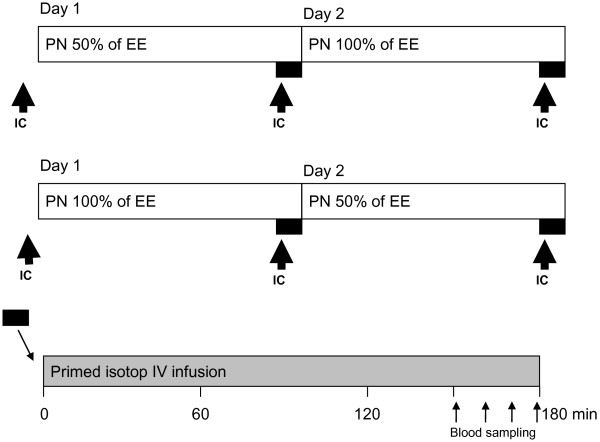
A schematic illustration of the study protocol. IC, indirect calorimetry; EE, energy expenditure; PN, parenteral nutrition; IV, intravenous.